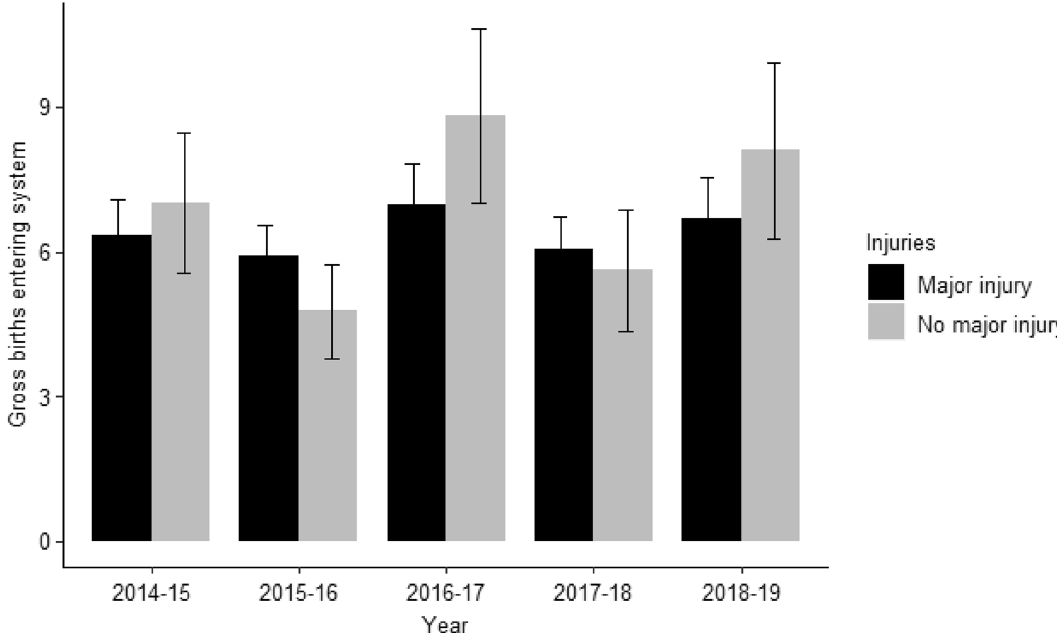
Figure 7. Gross amount of individuals (with SE) with a major injury (black), and no major injury (grey) entering SAMPA between years i and i + 1 with standard error. Gross ‘births’ are calculated as a derived POPAN